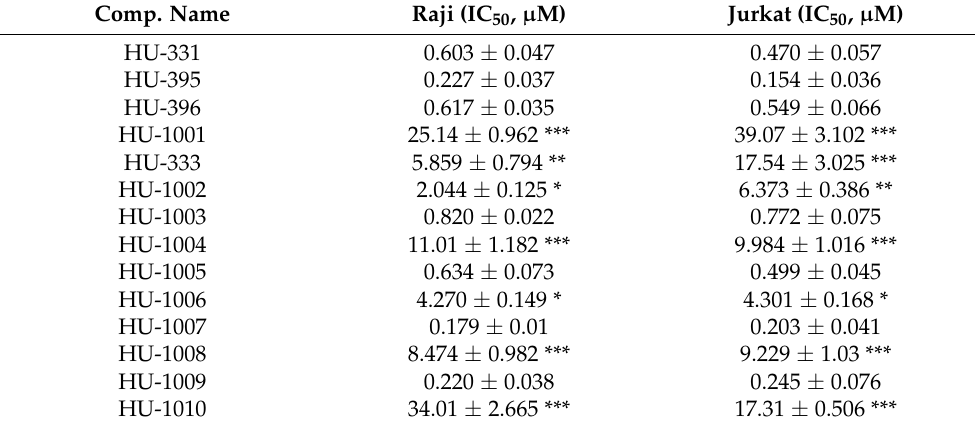
Table 1. IC 50 values of cannabinoid quinones on the Raji and Jurkat cell lines. Comp. Name Raji (IC 50 , µ